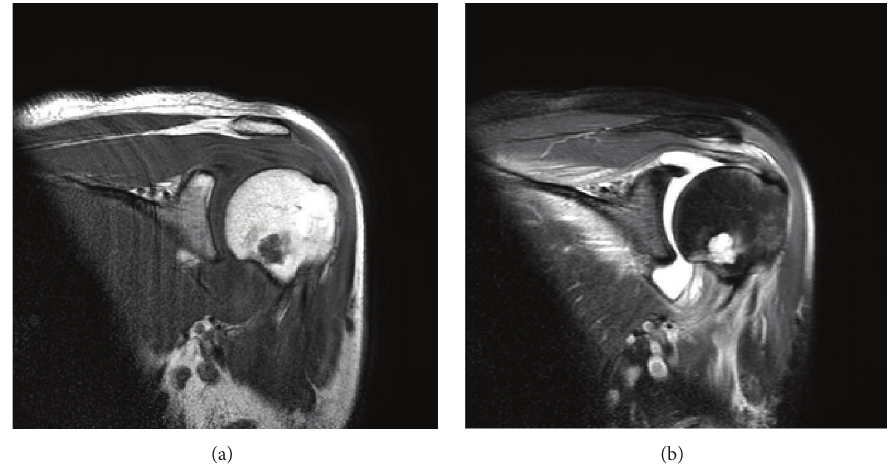
Figure 1: Selected MRI T1 (a) and T2 (b) sagittal cuts demonstrating the large joint effusion and proximal humerus lesion.